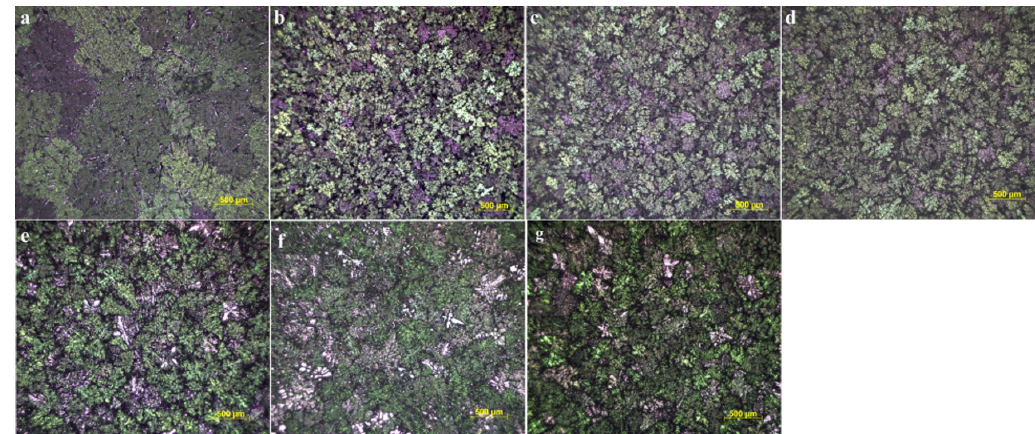
Figure 6. Al9Si1Fe”X”NbB alloy, where: a) X=0%. b) X=0.02%. c) X=0.05%. d) X=0.1%. e) X=0.2%. f) X=0.5%. g) X=1%.